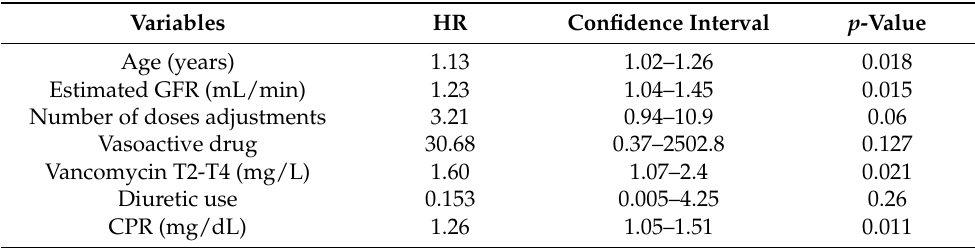
Table 6. Cox regression of the associated variables to death in patients using vancomycin admitted to the ICU.